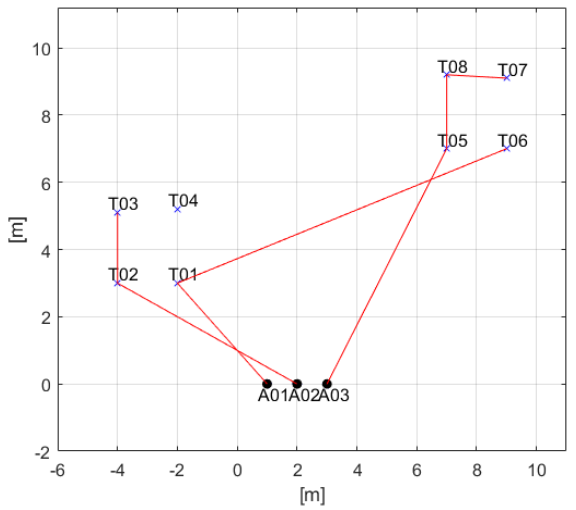
Figure 7. 2-D result of TACTAR for a complicated case applying a modified time-discounted reward scheme.